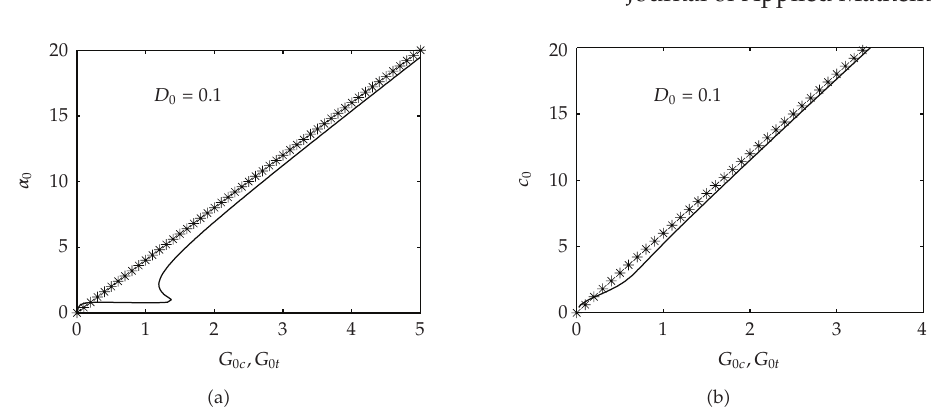
Figure 2: Comparison of (cid:3) a (cid:4) the growth of the wave number, and (cid:3) b (cid:4) wave speed with increasing buoyancy for the limiting case (cid:3) (cid:16) (cid:16) (cid:16) (cid:4) and the full eigenrelation (cid:3) — (cid:4) when D 0 (cid:8) 0 . 1.